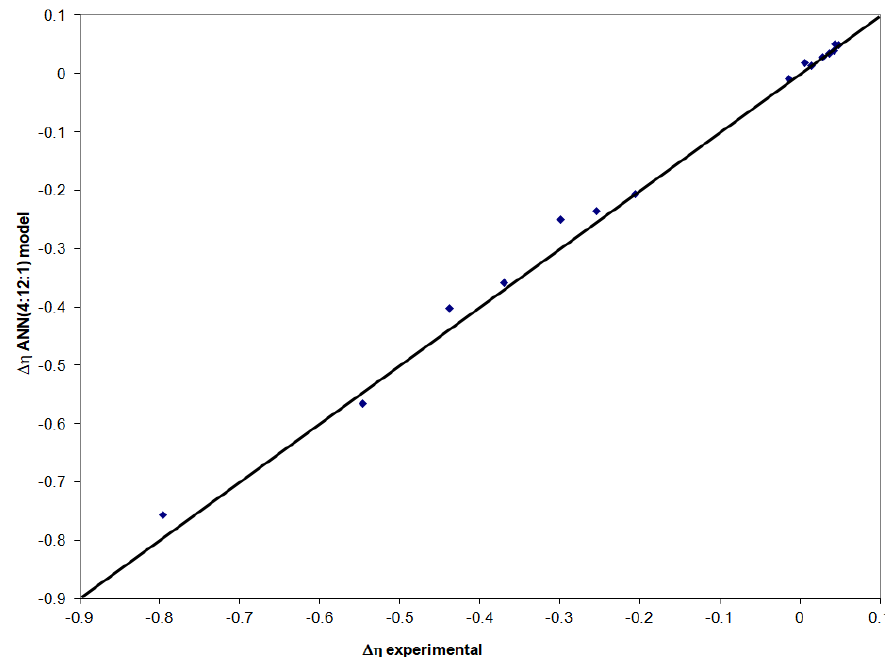
Figure 7. Evaluation of the ANN(4:12:1) model in the validation stage.